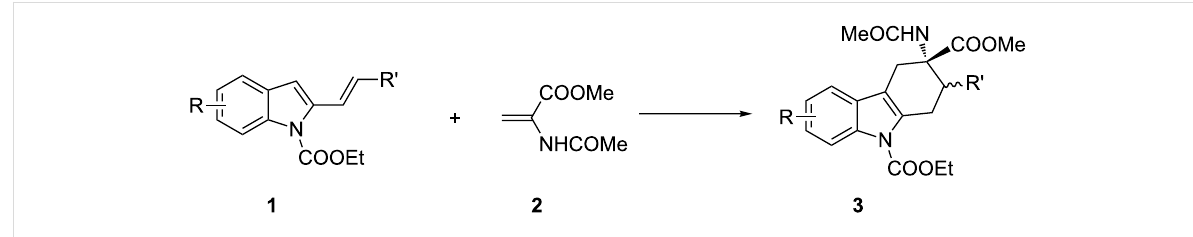
Scheme 1: Planned Diels–Alder reactions for the synthesis of tetrahydrocarbazoles as constrained analogues of